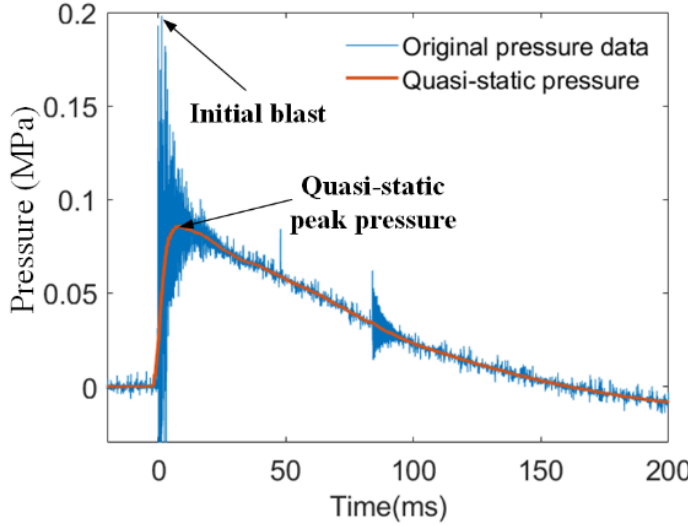
Figure 3. Typical original pressure data and quasi-static peak pressure.